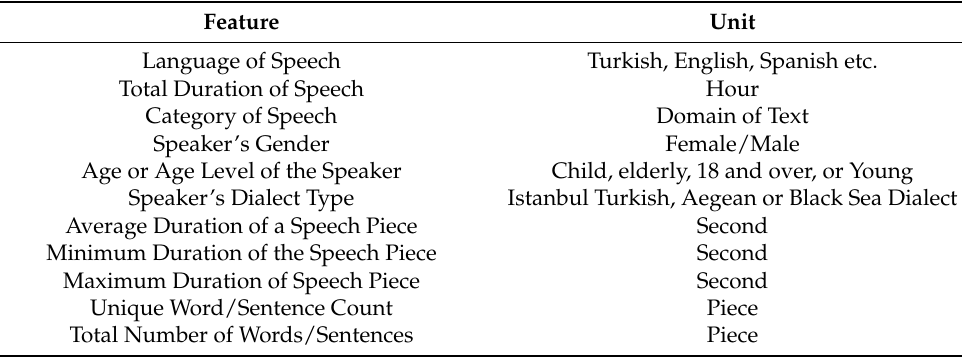
Table 1. Table of characteristics/units for the corpus. Feature Unit Language of Speech Turkish, English, Spanish etc. Total Duration of Speech Hour Category of Speech Domain of Text Speaker’s Gender Female/Male Age or Age Level of the Speaker Child, elderly, 18 and over, or Young Speaker’s Dialect Type Average Duration of a Speech Piece Second Minimum Duration of the Speech Piece Second Maximum Duration of Speech Piece Second Unique Word/Sentence Count Piece Total Number of Words/Sentences